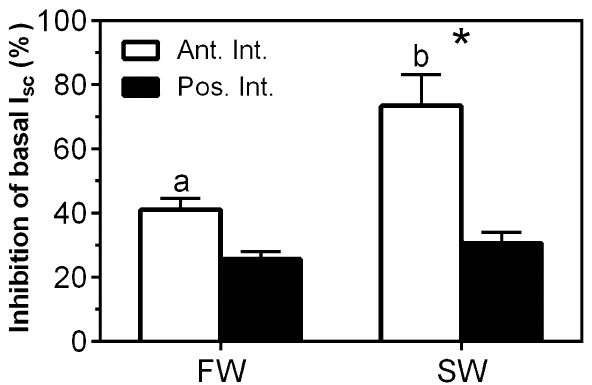
Figure 6. Percent inhibition of baseline short circuit current (%) in response to luminal indapamide (0.4 mM) in FW- and SW-acclimated juvenile sea lamprey. All data are the mean ± SEM (n = 5–8). Different letters indicate significant differences within intestinal regions between environmental salinities. *Significant differences between intestinal regions within environmental salinities (two-way ANOVA, Tukey’s post hoc).